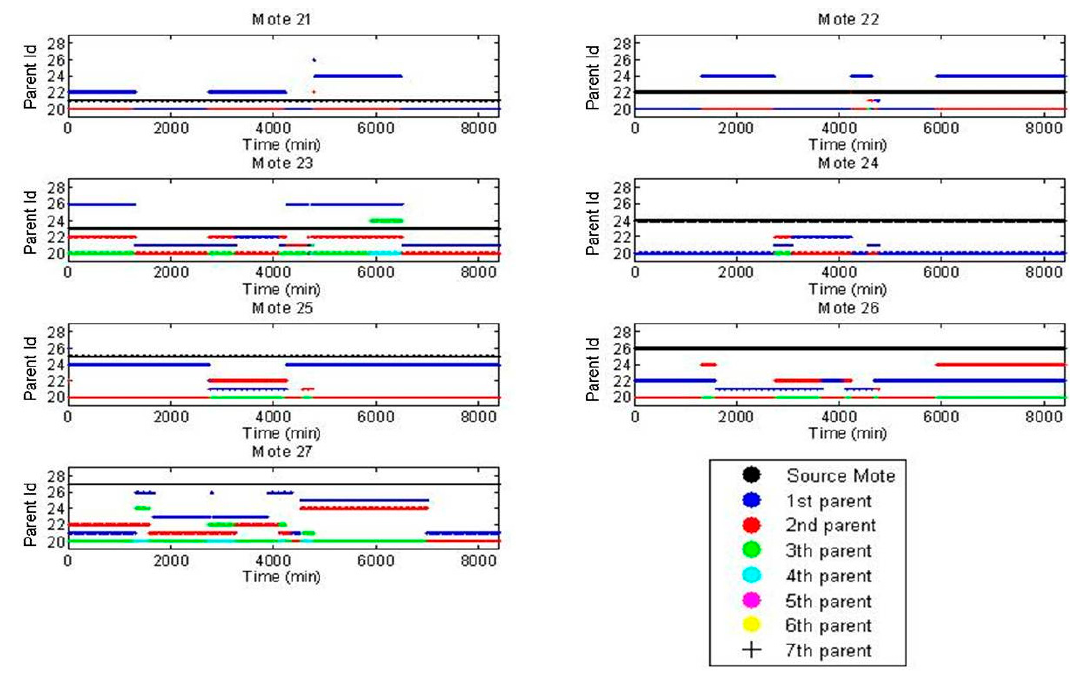
Figure 10. Route distribution for each mote using the CTP protocol in Experiment 1.